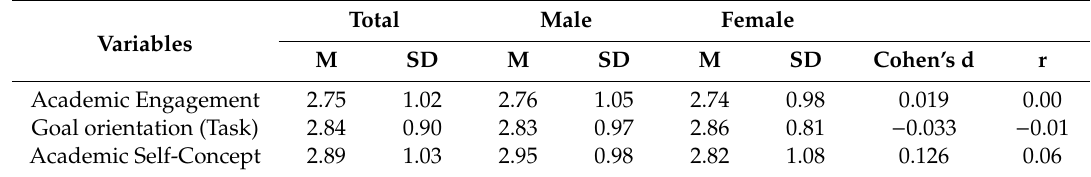
Results by descriptive variables of academic engagement, goal orientation (task), and academic self-concept.